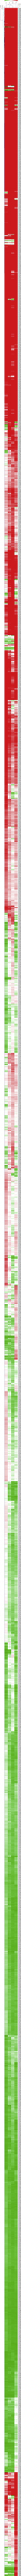
Hierarchical clustering analysis of four transcriptomic profiles: +P + Fe, -Fe apex, -Fe cluster and -P cluster of lupin roots, output from TMeV software (defaults parameters were used with distance metric: Euclidean distance, linkage method: complete; N = 3, q-value <0.05). From green (low values) to red (high values), color scale refers to the FPKM values of transcripts.